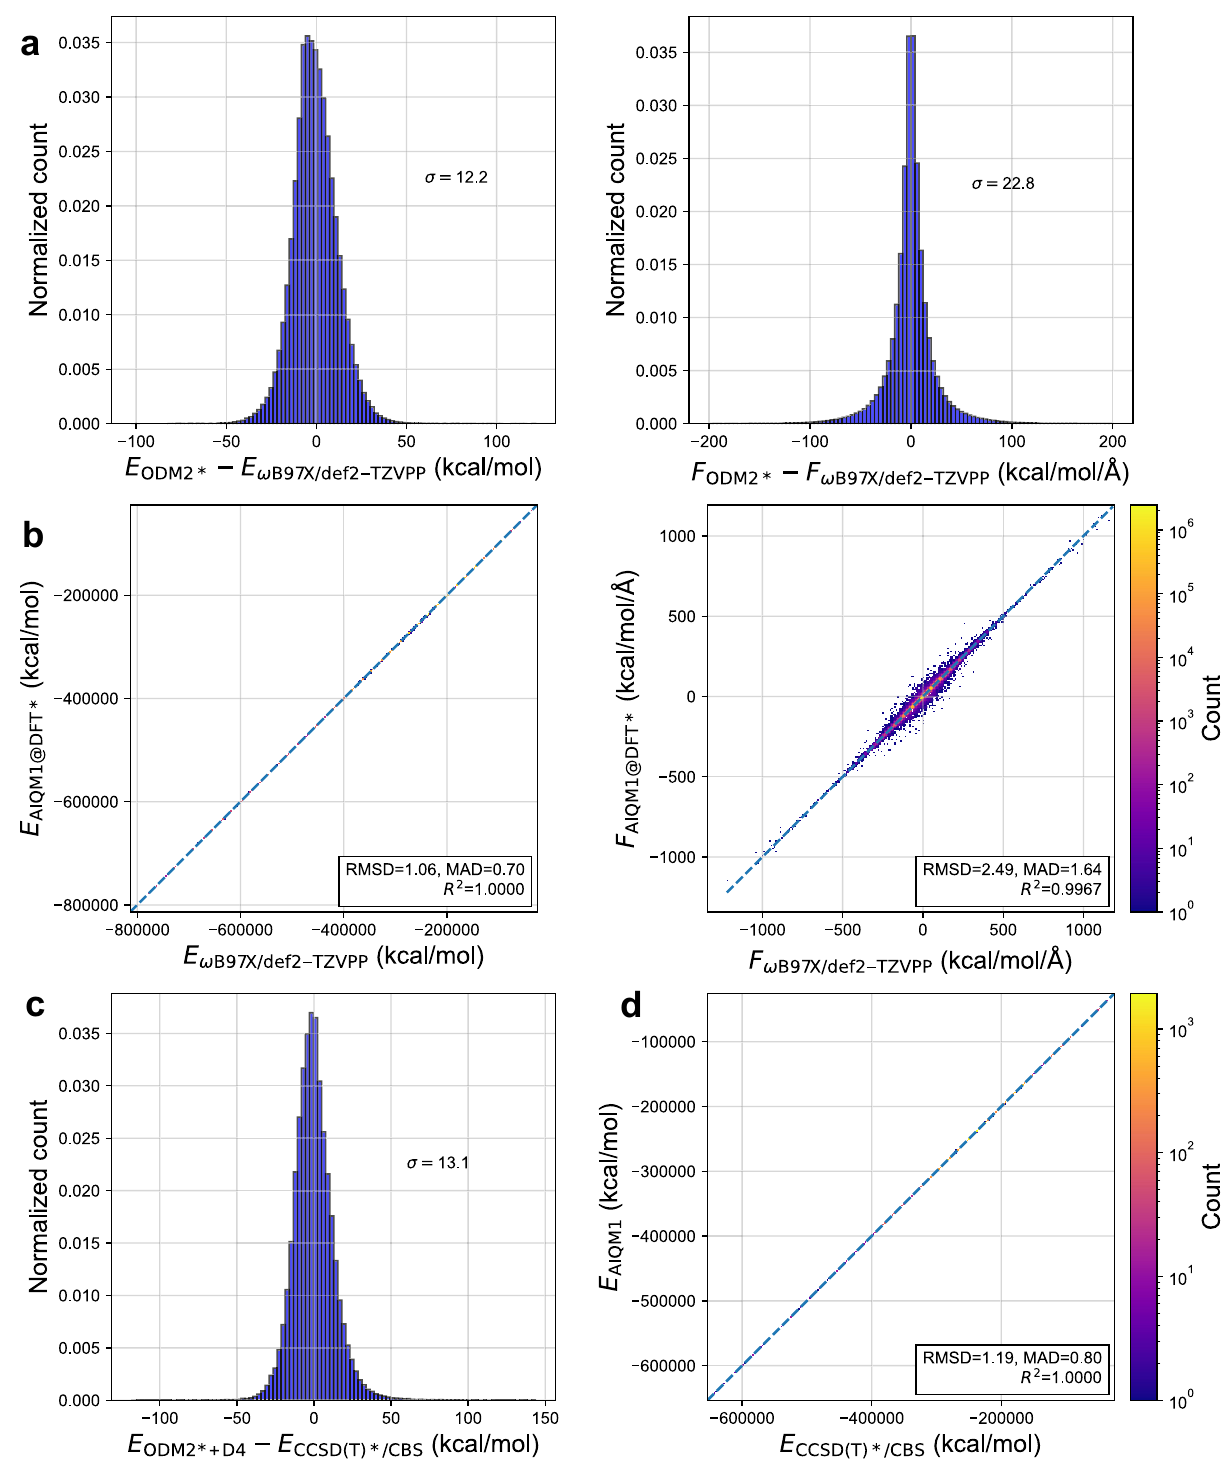
Fig. 3 Correlation between the arti fi cial intelligence – quantum mechanical method 1 (AIQM1) variants and reference methods for the hold-out test set. a Histogram of learned centered differences between ODM2* and ω B97X/def2-TZVPP energies ( E , left) and forces ( F , right). b Correlation between AIQM1@DFT* and ω B97X/def2-TZVPP energies and forces. c Histogram of learned centered differences between ODM2* + D4 and CCSD(T)*/CBS energies. d Correlation between AIQM1 and CCSD(T)*/CBS energies. Root-mean-squared deviations (RMSDs), standard deviations ( σ ), mean absolute deviations (MADs), and squared correlation coef fi cients R 2 are also shown on the plots. Errors for energies are in kcal/mol, for forces — in kcal/mol/Å.